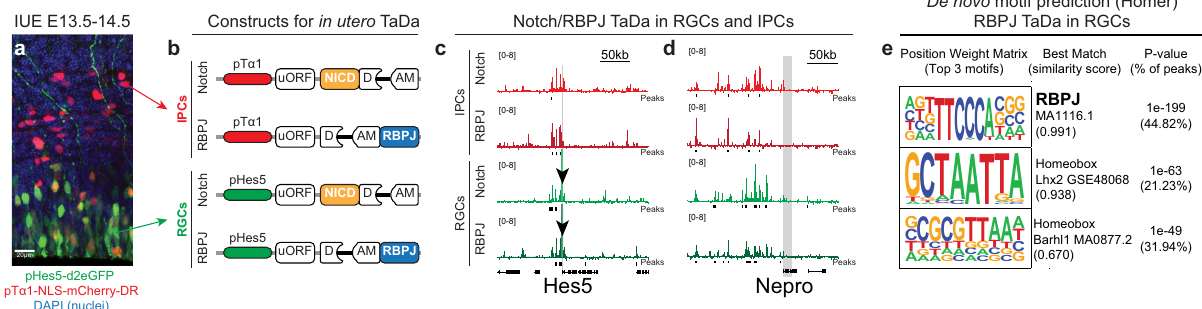
Fig. 2 Cell-type speci fi c in utero TaDa of NOTCH and RBPJ. a IUE of plasmids with destabilized fl uorescent proteins under control of Hes5 and T α 1 promoters (n = 1). Staining for DAPI (nuclei, blue), GFP (green) and mCherry (red). Scale bar, 20 µ m. b Constructs used for NOTCH and RBPJ TaDa in RGCs and IPCs. c , d NOTCH and RBPJ binding peaks near known target genes (grey shading) in RGCs and IPCs. Arrowheads indicate Hes5 -promoter present in p Hes5 -plasmids. e Motif detection at RBPJ binding peaks in